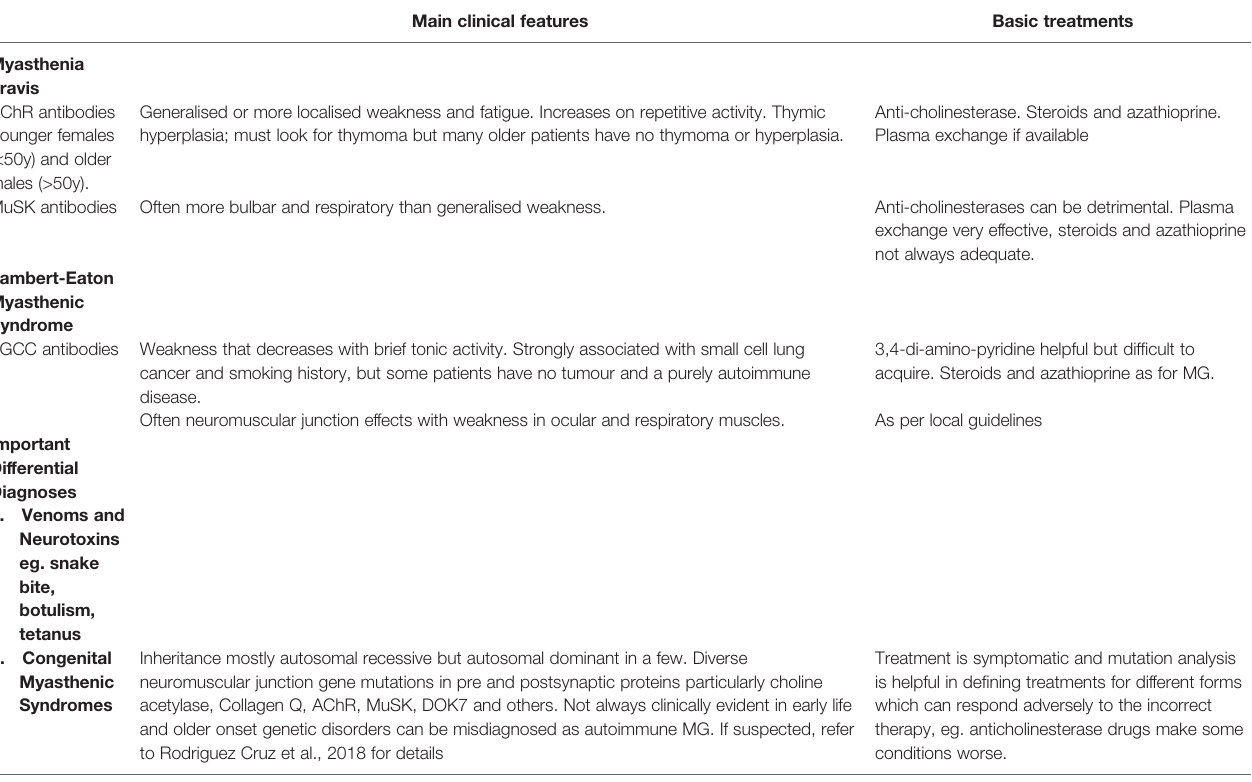
TABLE 4 | Disorders of neuromuscular transmission and differential